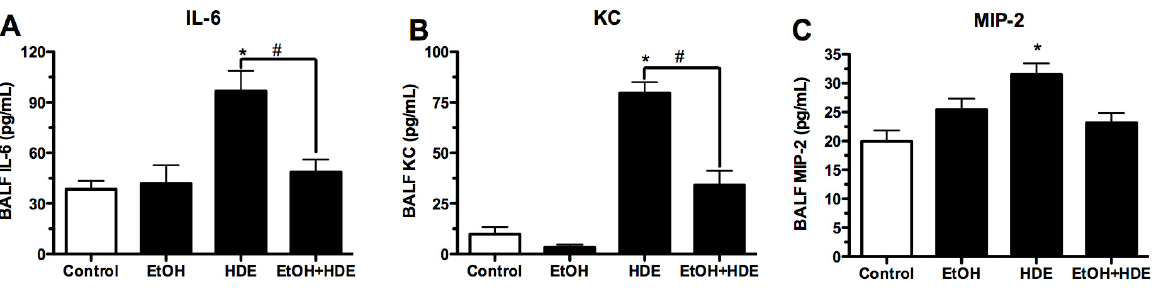
Figure 4. C57BL/6 Mice were fed alcohol (EtOH) for 6 weeks and were exposed to 12.5% HDE intranasally for 3 weeks ( n = 5). Cytokine in the BAL fluid collected from these mice was quantified by ELISA. HDE instillation elevated TNF release more than 3-fold vs . control (* p < 0.05 vs . control, ANOVA, Bonferroni post-test). TNF- α levels were reduced by 65% in the alcohol + HDE group compared to the HDE only group (117.6/334.1 pg/mL). ( # p < 0.05 vs . HDE, ANOVA, Bonferroni